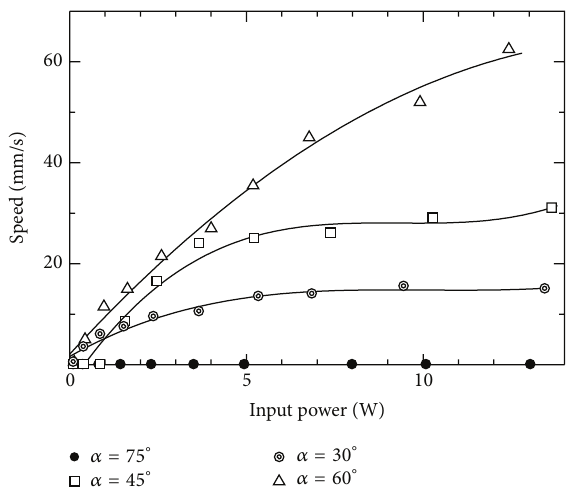
Figure 5: Relationship between input power and speed when the attractive force was set to 2.48